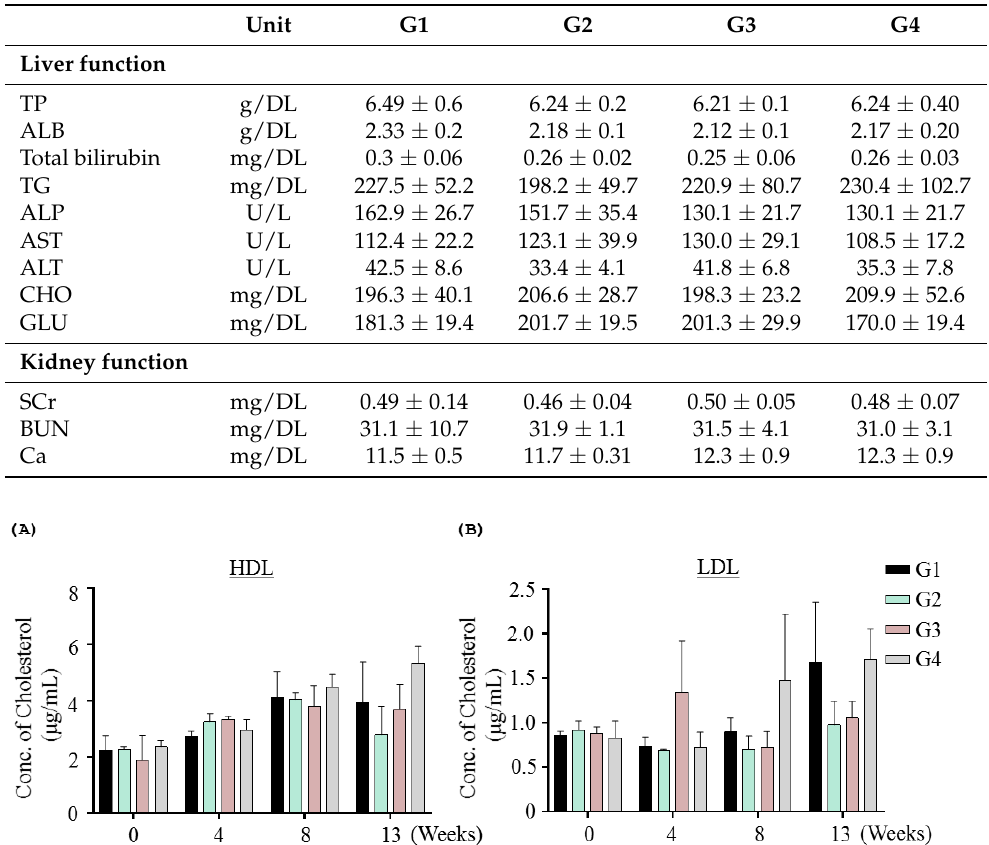
Table 2. Effects of repeated dose toxicity study of INO95 and INO20 on clinical biochemistry results. The average ± SD of parameters is given ( n = 5).